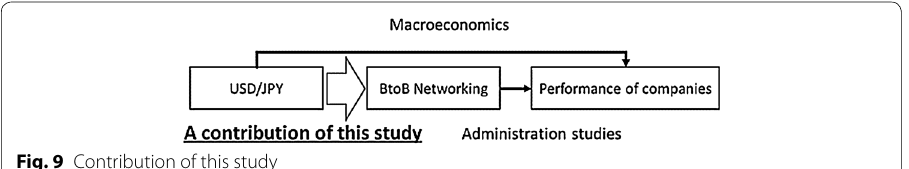
Fig. 9 Contribution of this